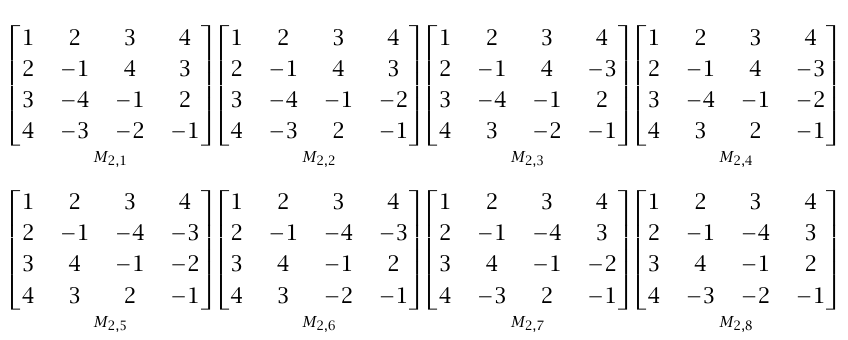
Figure 3.2 . Eight ⊗ -matrices M 2 ,v satisfying (3.3). Note that M 2 , 3 and M 2 , 7 are transposes and that both generate Cayley loops isomorphic to the quater- nion